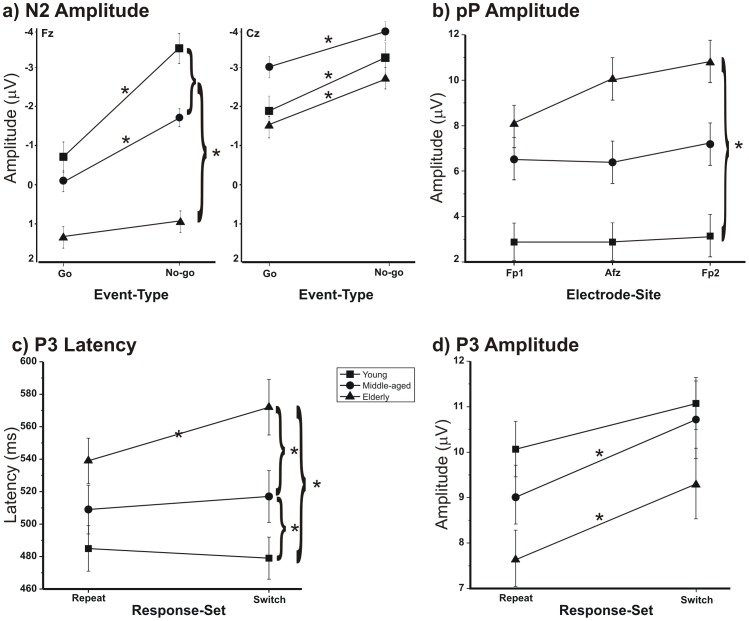
The significant interactions for the N2 and P3 components and the prefrontal positivity (pP).The vertical bars indicate the standard errors. The asterisks indicate a significant difference between the means of post-hoc tests with an alpha value of 0.05.